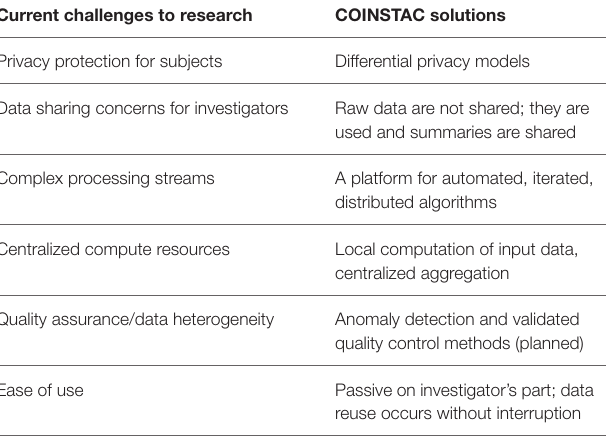
TABLE 1 | The challenges addressed by COINSTAC. Current challenges to